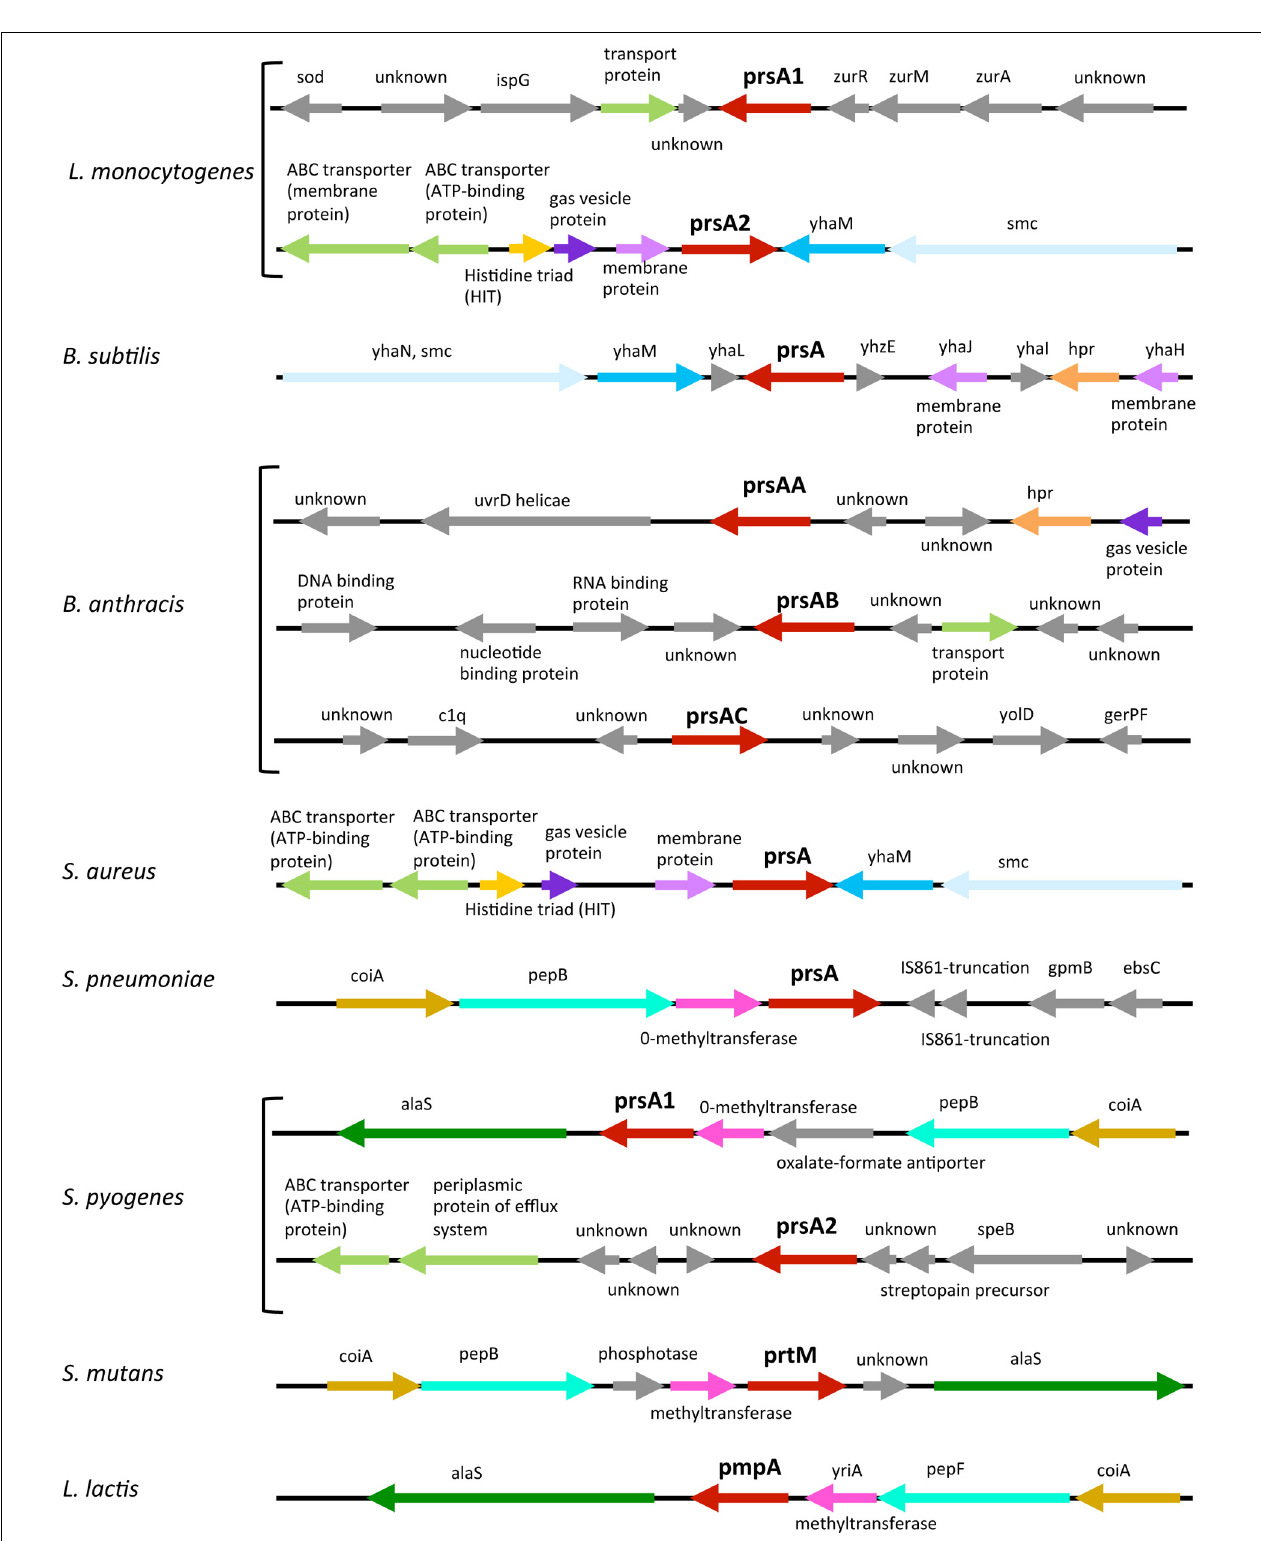
FIGURE 2 | Comparative organization of prsA -like loci. The prsA -like loci from eight Gram-positive bacteria are shown where arrows represent open- reading frames. Genes with similar functions have the same color while genes that have unrelated functions are in gray. The annotation of genes mentioned